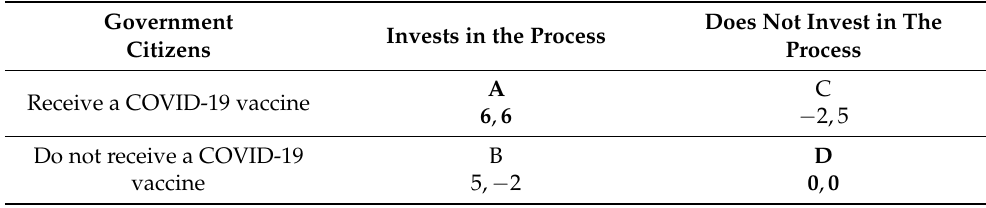
Table 4. Game matrices for the